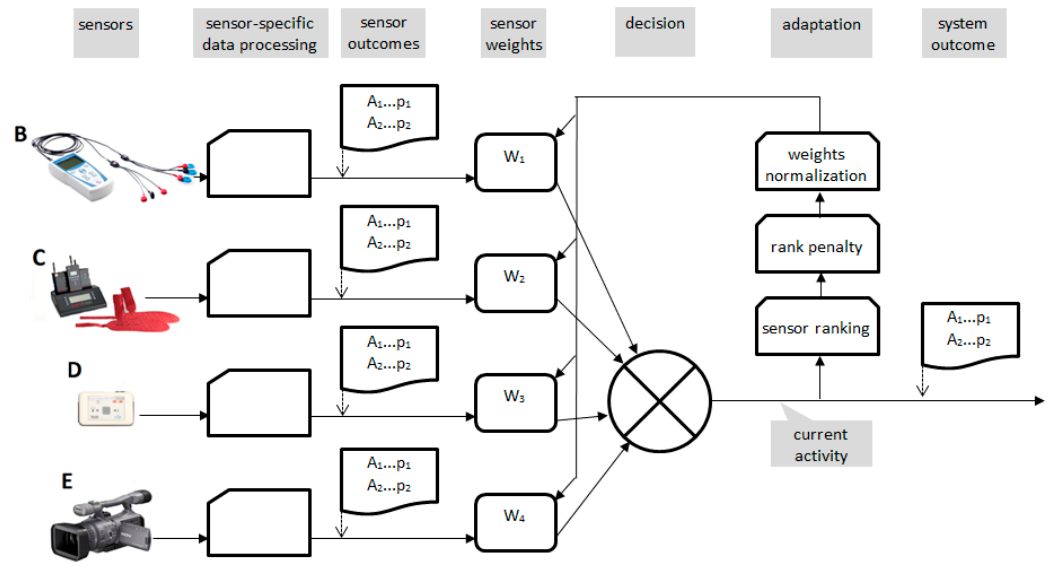
Figure 6. Flow of sensors’ data modulator adapting a multimodal assisted living system to presently detected behavior.